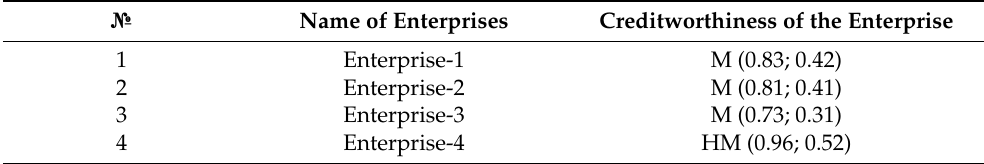
Table 6. Output variable “Creditworthiness of the